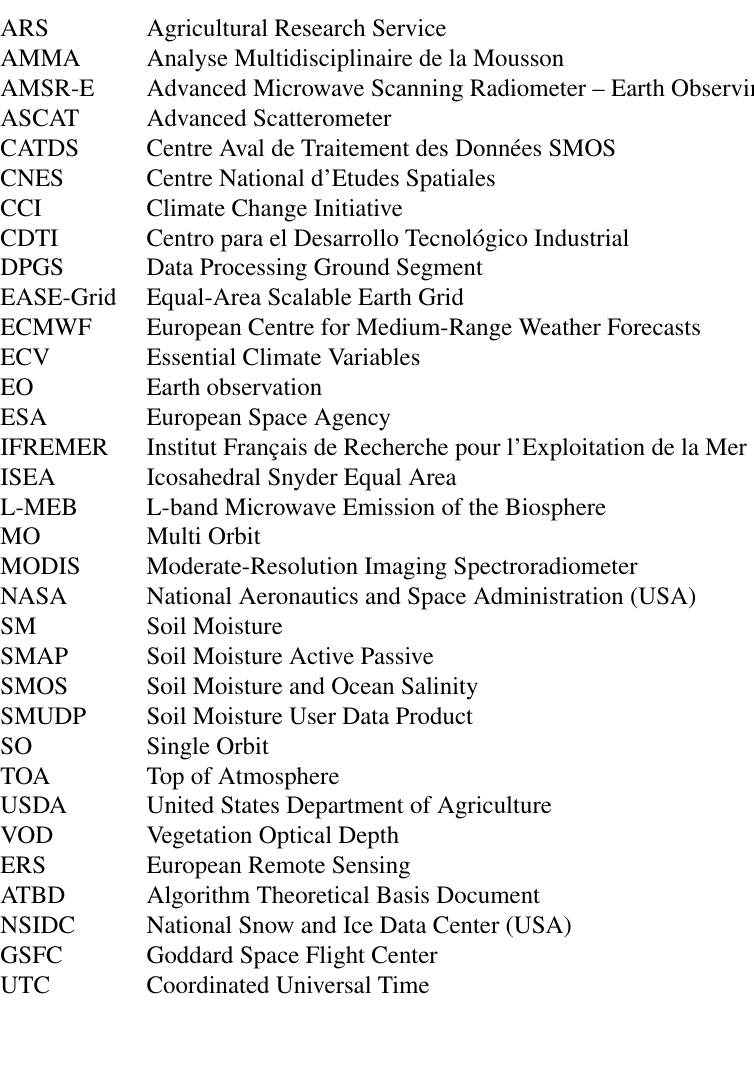
Algorithm Theoretical Basis